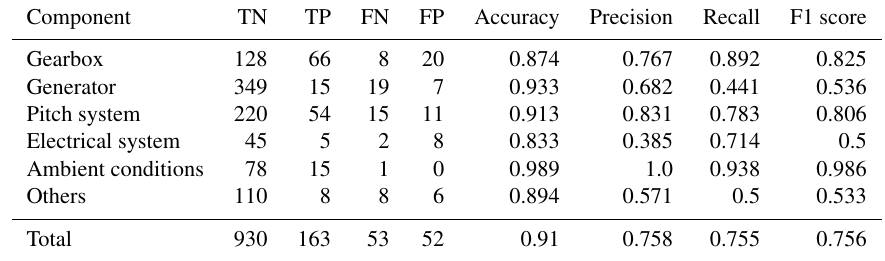
Table C1. Results validation per component for best configuration (Laplace/SD-max/ α cost = 80) on 1-year signals.